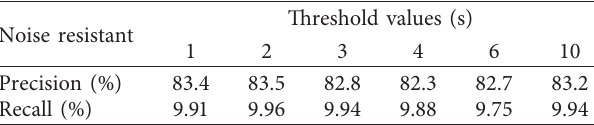
Table 10: Retrieval accuracy observed at different threshold values using Corel 1k dataset. Highest retrieval accuracy is achieved at s � 2.